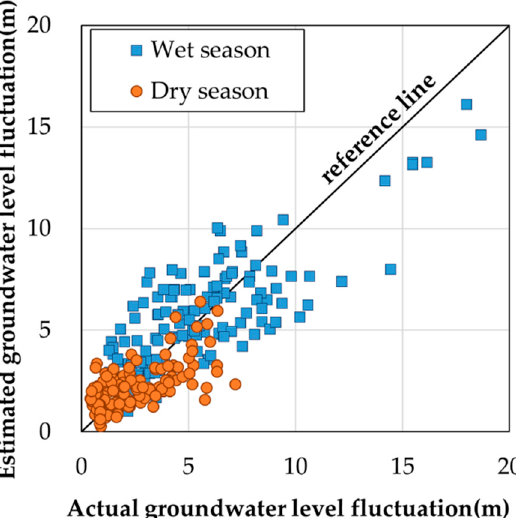
Figure 14. Comparison between the observed and estimated groundwater level fluctuation in the wet and dry seasons.